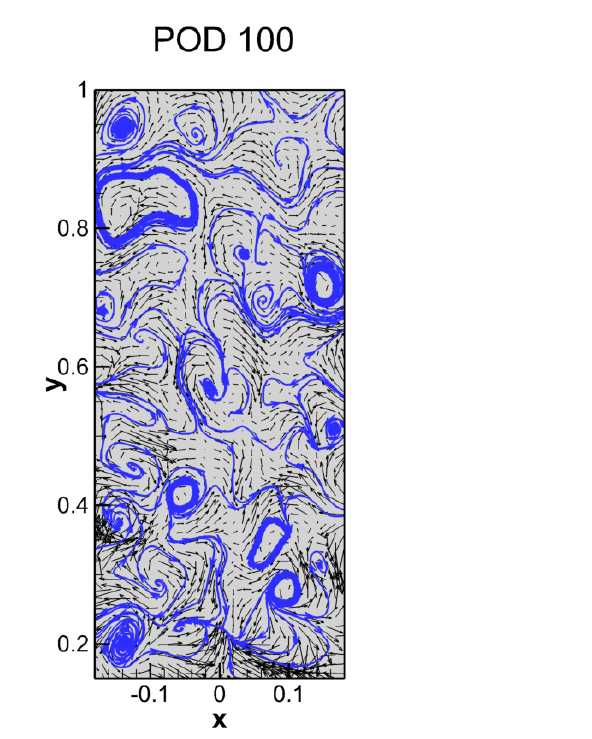
Fig. 14. Velocity POD mode No. 100, 0.23% TKE.